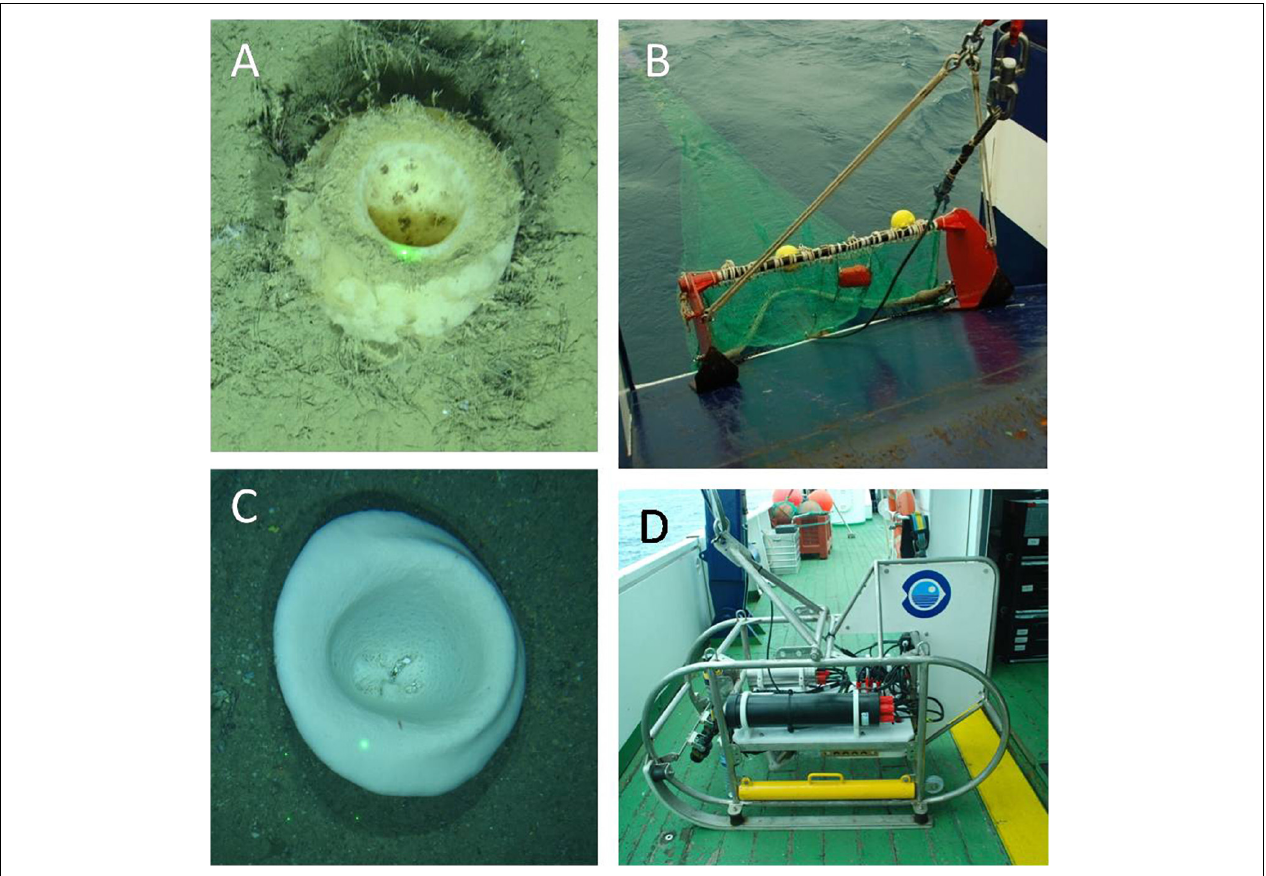
FIGURE 1 | Sponges images and their samplers: (A) Pheronema carpenteri specimen, and (B) beam trawl, the sampler used for its quantification; (C) Asconema setubalense specimen, and (D) ROTV, the sampler used for its